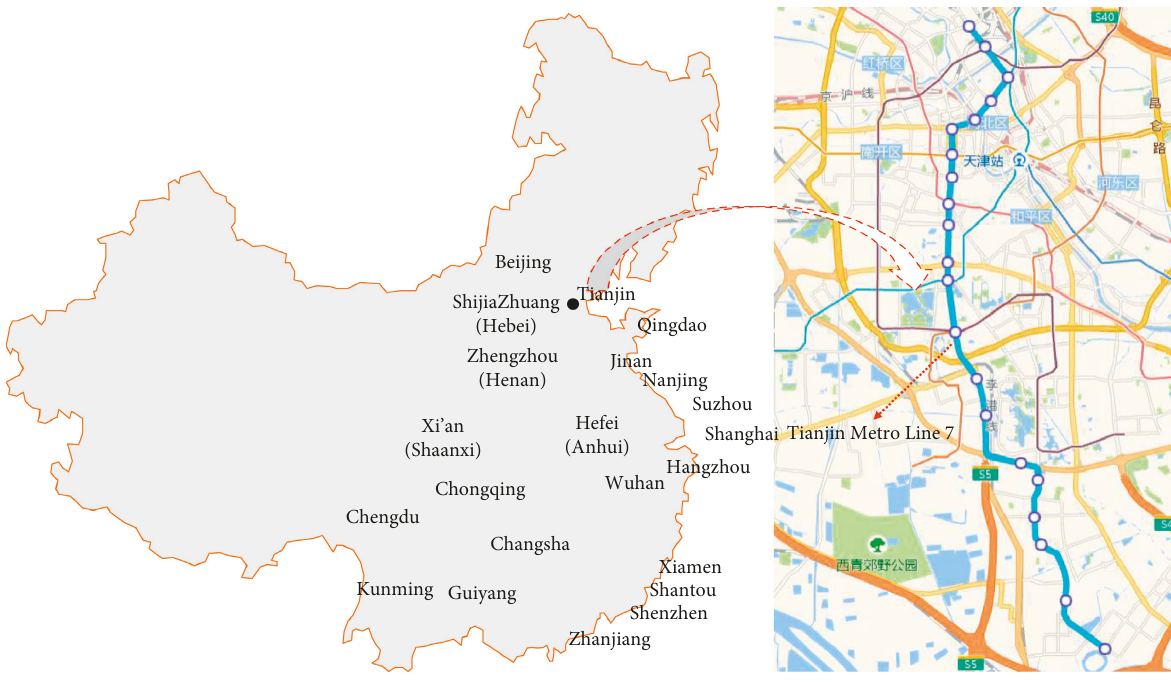
Figure 1: The location of Tianjin Metro Line